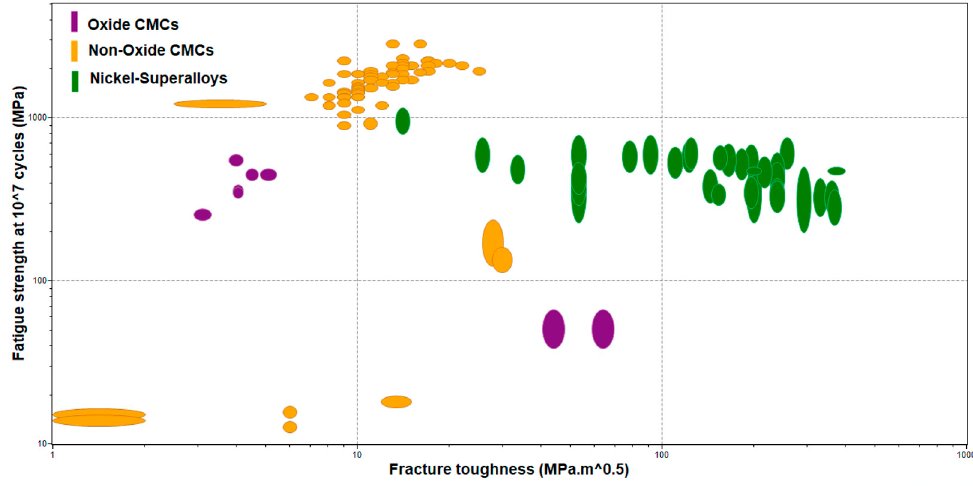
Figure 9. Comparison of fatigue strength vs. fracture toughness of the available CMCs.